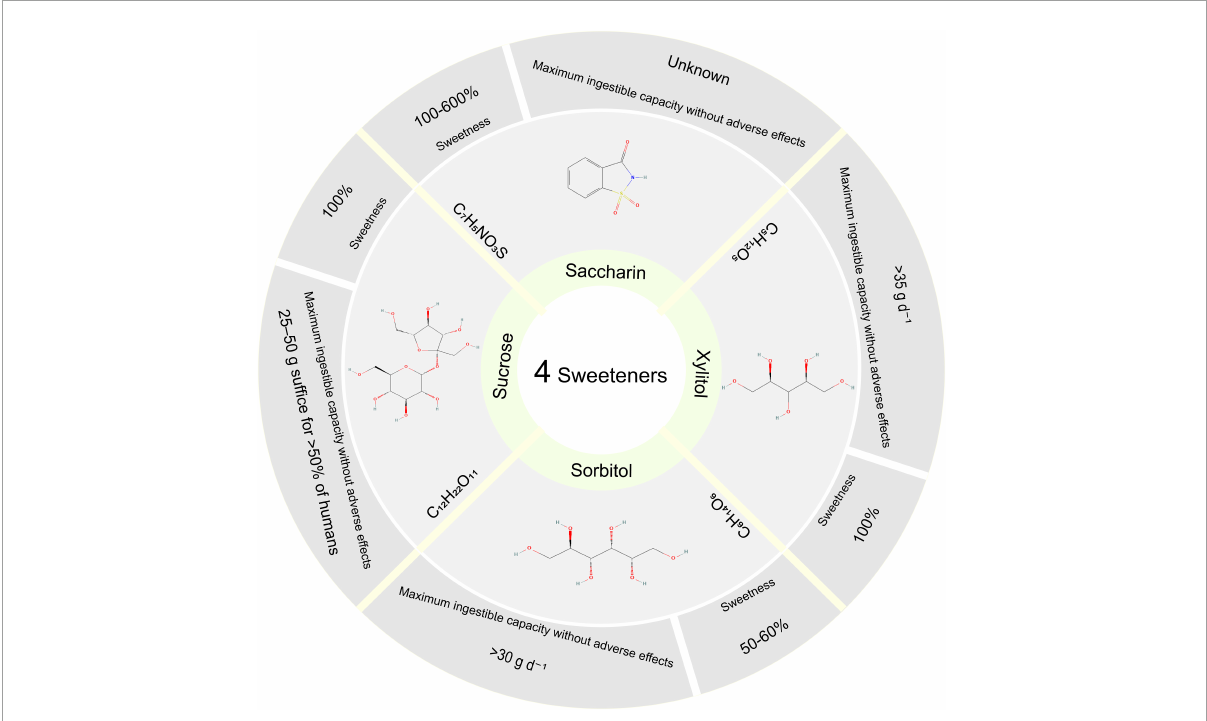
FIGURE1 Four sweetener structures, sweetness, and maximum ingestible capacity without adverse effects. Sweetness (vs. Sucrose). Maximum ingestible capacity without Xylitol and Sorbitol’s adverse effects without sucrose’s damaging effects. Structure from PubChem Substance